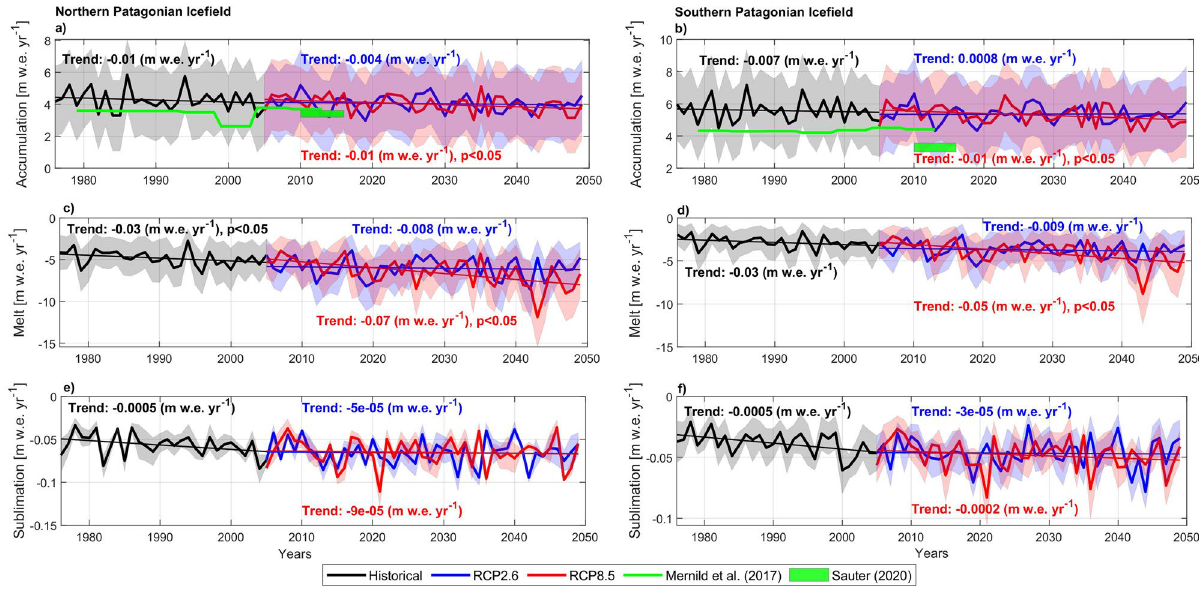
Figure 4. Annual values (hydrological years 1976/77–2049/50) and linear trends of the SMB components in m w.e. in NPI and SPI for the historical period and the two RCPs. ( a , c , e ) are accumulation, melt and sublimation in the NPI and ( b , d , f ) are accumulation, melt and sublimation in the SPI. Trends with the 95% confidence interval are shown. Significant trends are also indicated when p < 0.05. Trends in melt for RCP2.6 are significant where estimated between 1976 and 2050, reaching 0.03 ± 0.01 m w.e. in NPI and 0.02 ± 0.009 m w.e. in